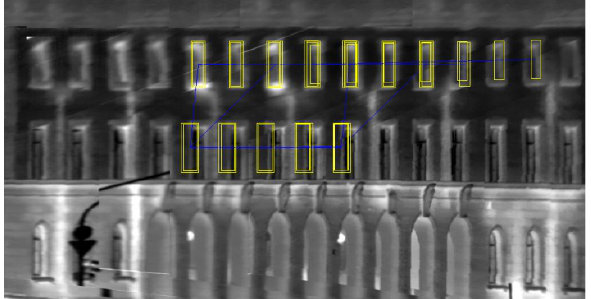
Figure 5. Result with “rows first” productions Figure 5 displays again the best five resulting instances, two lattices and three rows. Both lattices contain 2x5 windows and the vertical spacing is estimated roughly correct. The upper row alone is less complete than in Section 3.1 (one row of eight members and one of seven with overlap). But there are also results with correct generator and window size on the middle row (one row of five members). Still, the phase of the middle rows is estimated wrongly; they are all displaced left and a little upward. Below, on the first floor again nothing is